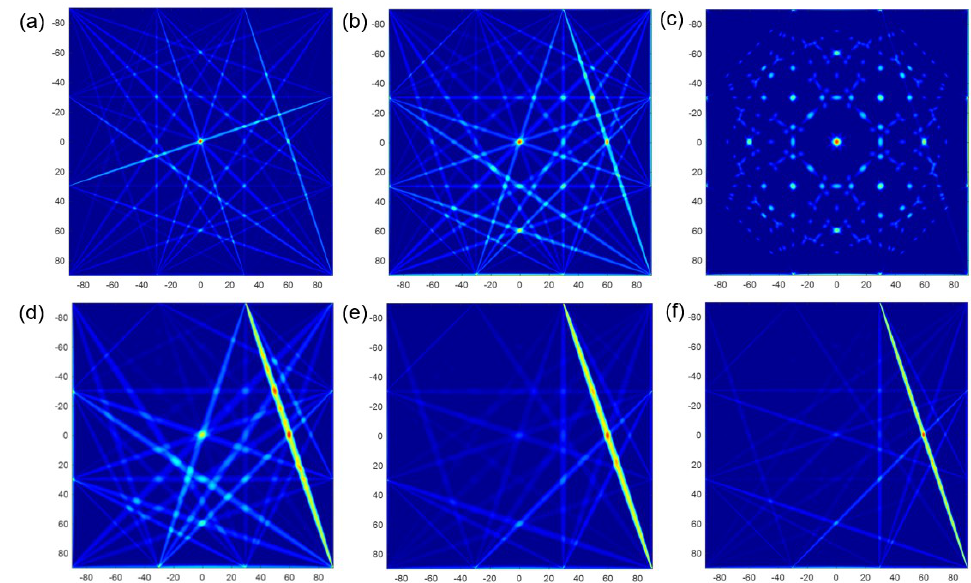
Figure 6. Simulated images based on different corrosion characteristic parameters: ( a ) SDC. ( b ) RMSE. ( c ) E 1. ( d ) E 2. ( e ) E 3. ( f ) NCM. Subsequently, the simulated images were enlarged to evaluate the imaging clarity.